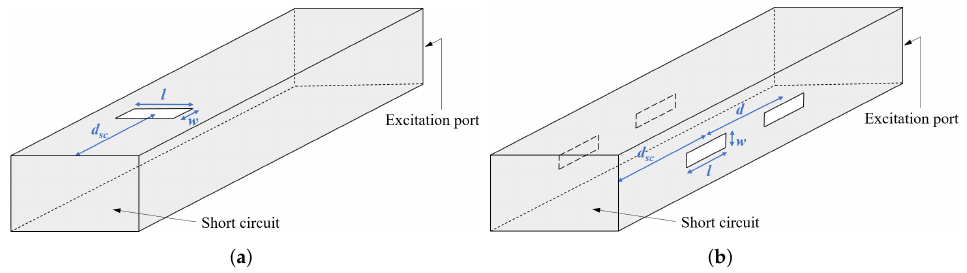
Figure 13. Alternative slotted waveguide antenna designs: ( a ) Waveguide antenna with one trans- verse slot, ( b ) waveguide array with two pairs of longitudinal slots at both narrow waveguide walls.